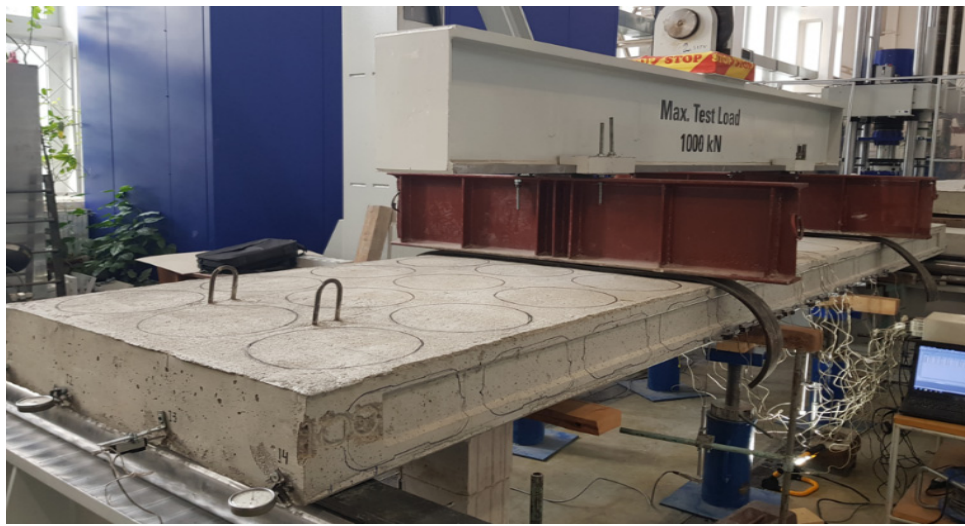
Figure 7. General view of the slab test.